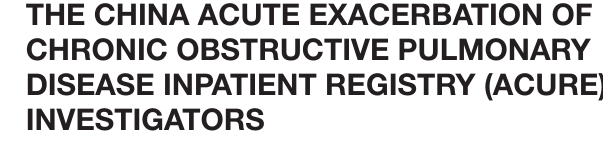
FIGURE 3 | Kaplan–Meier curve and log-rank test for day 30 outcomes (a) recurrent exacerbation ( p = 0.4103) and (b) exacerbation-related readmission ( p = 0.4777) between ACO phenotype and patients without asthma or bronchiectasis in hospitalized patients with AECOPD. (C) Kaplan–Meier curve and log-rank test for day 30 outcomes between BCO phenotype and patients without asthma or bronchiectasis in hospitalized patients with AECOPD. Kaplan–Meier curve and log-rank test for day 30 outcomes (a) recurrent exacerbation ( P = 0.3707) and (b) exacerbation-related readmission ( P = 0.3768) between BCO phenotype and patients without asthma or bronchiectasis in hospitalized patients with AECOPD. (D) Kaplan–Meier curve and log-rank test for day 30 outcomes among four phenotypes in hospitalized patients with AECOPD. Kaplan–Meier curve and log-rank test for day 30 outcomes (a)